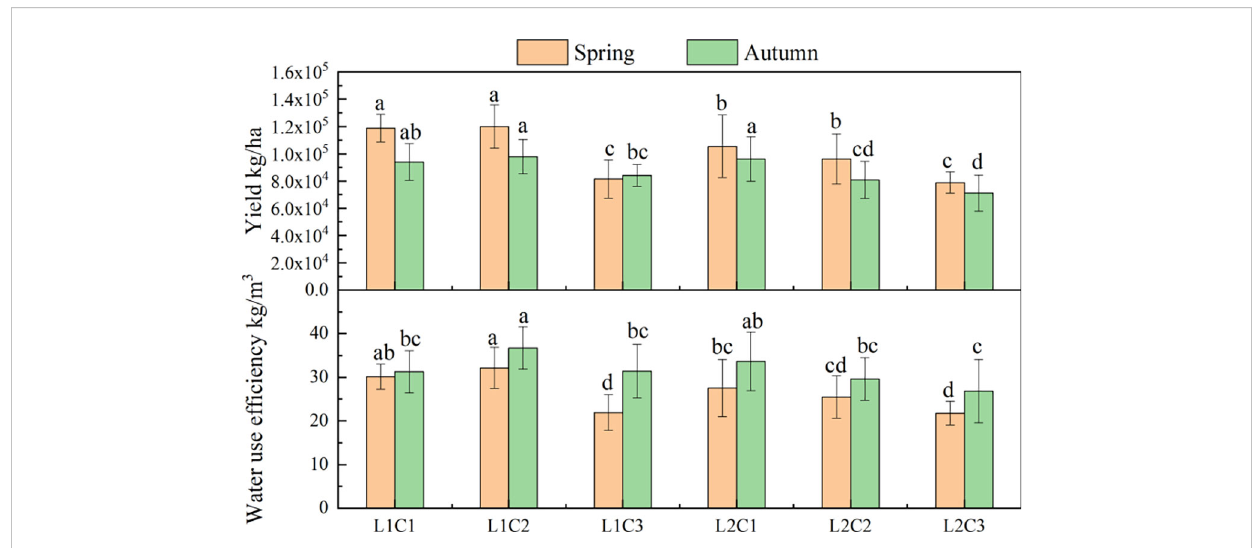
FIGURE 8 Yield and water use ef fi ciency of tomato. The data are all average±standard deviation in the fi gure, different letters in the same column meanS signi fi cant difference at 0.05 level, the same as